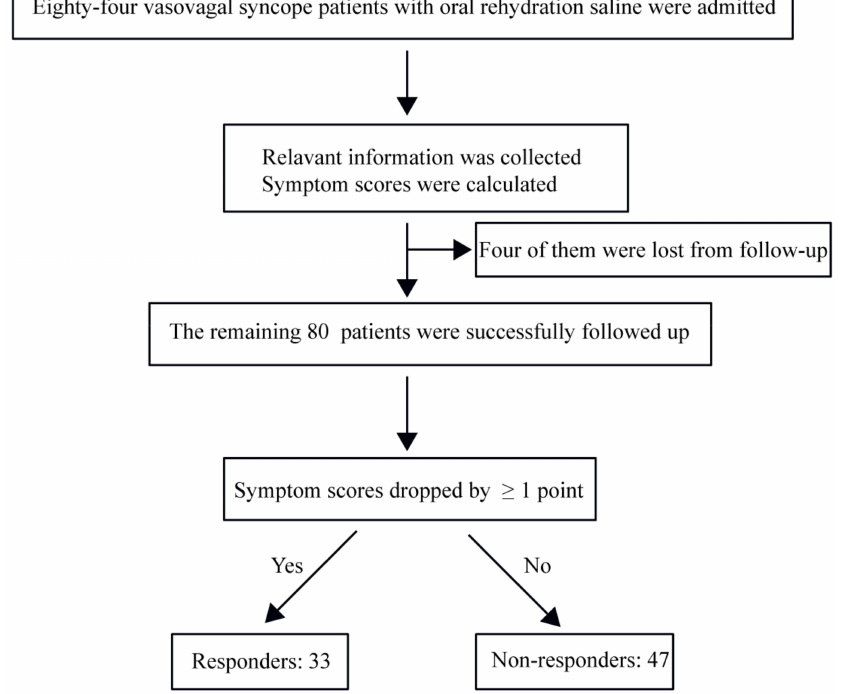
Figure 1. Flowchart of the study subject